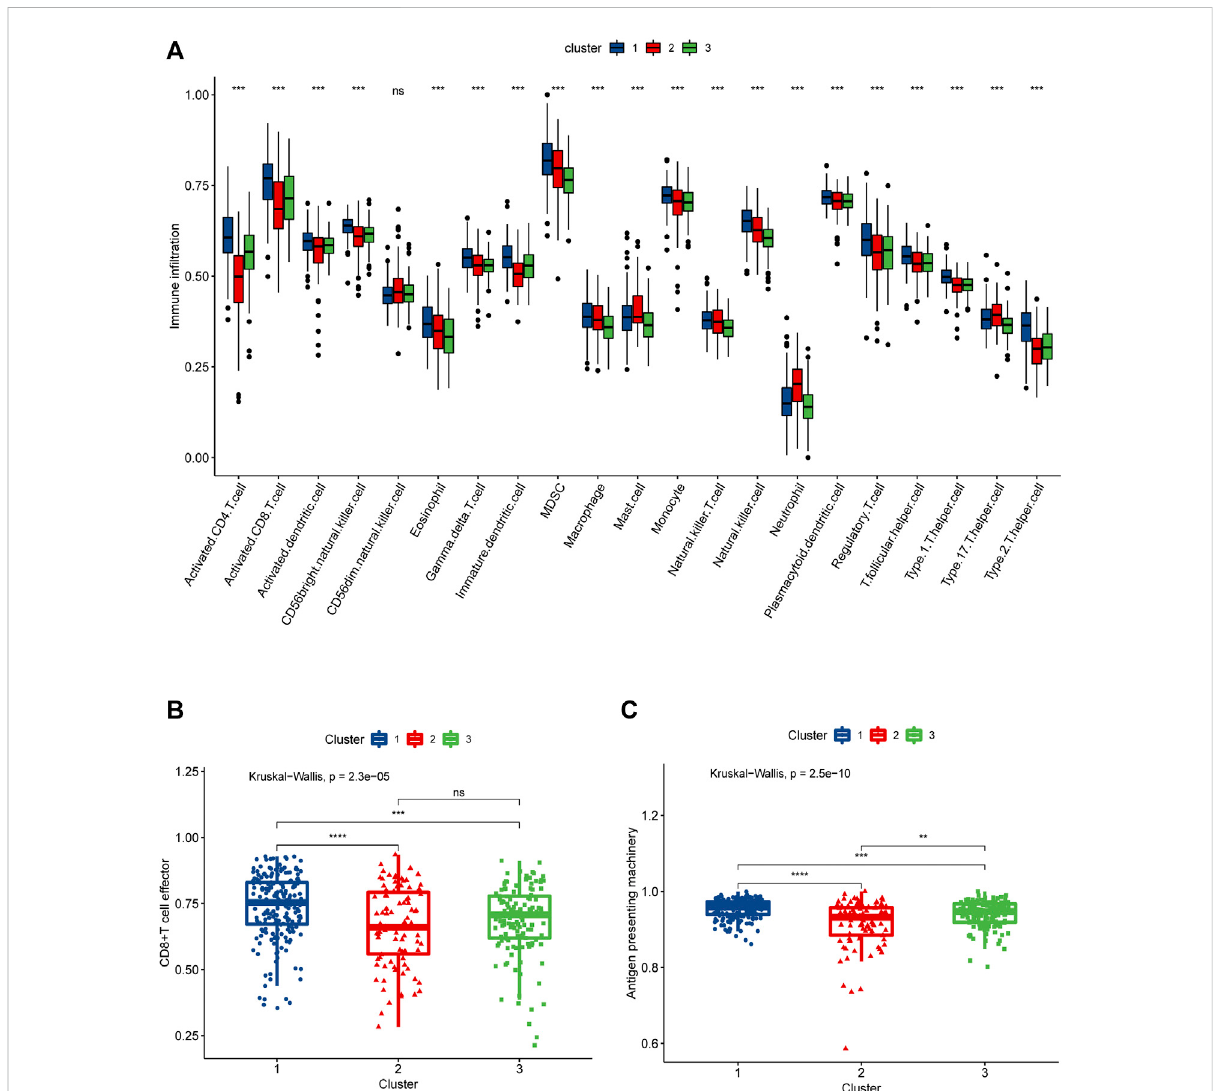
FIGURE 4 SsGSEA assessment of immune in fi ltration in three necroptosis-associated clusters (Cluster 1, Cluster 2 and Cluster 3). (A) Differences in the abundance of 21 in fi ltrating immune cells in the three necroptosis-related clusters, with Cluster 1 in blue, Cluster 2 in red and Cluster 3 in green. (B) Differences in CD8 + T cell effector scores between the three necroptosis-related clusters. (C) Differences in antigen presenting machinery scores between three necroptosis-related